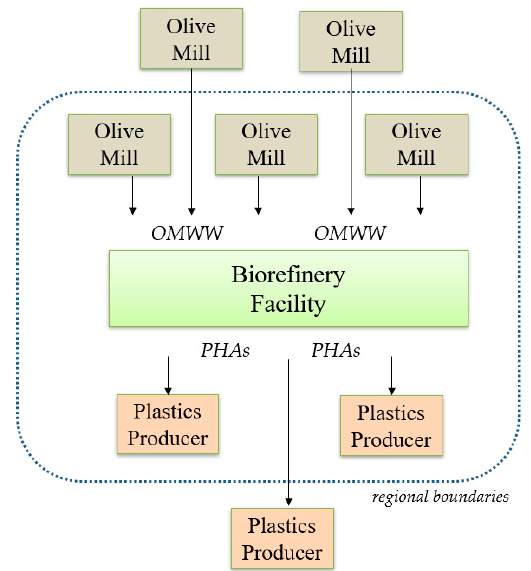
Figure 1. The biorefinery as an anchor tenant of an industrial symbiosis.